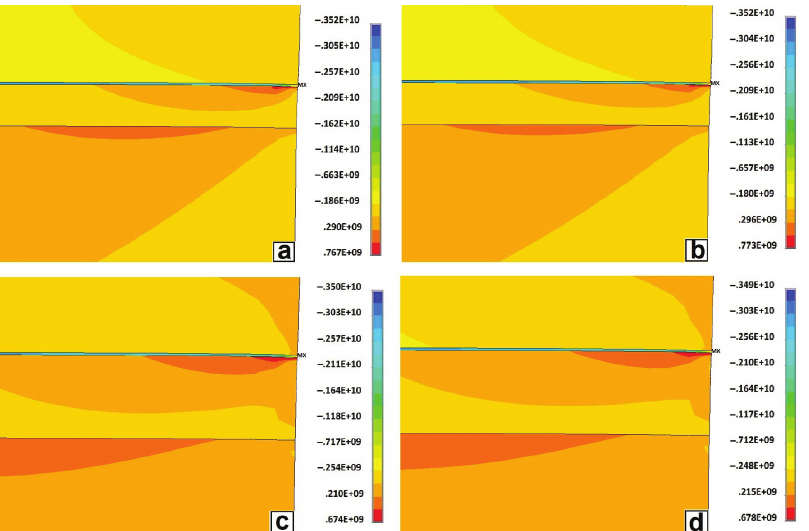
Figure 4: Contour plot of radial stress ( σ xx ) distribution in (left) traditional and (right) nanostructured YSZ coatings at 100 μ m (a, b) and 200 μ m (c, d) bond coat thicknesses.